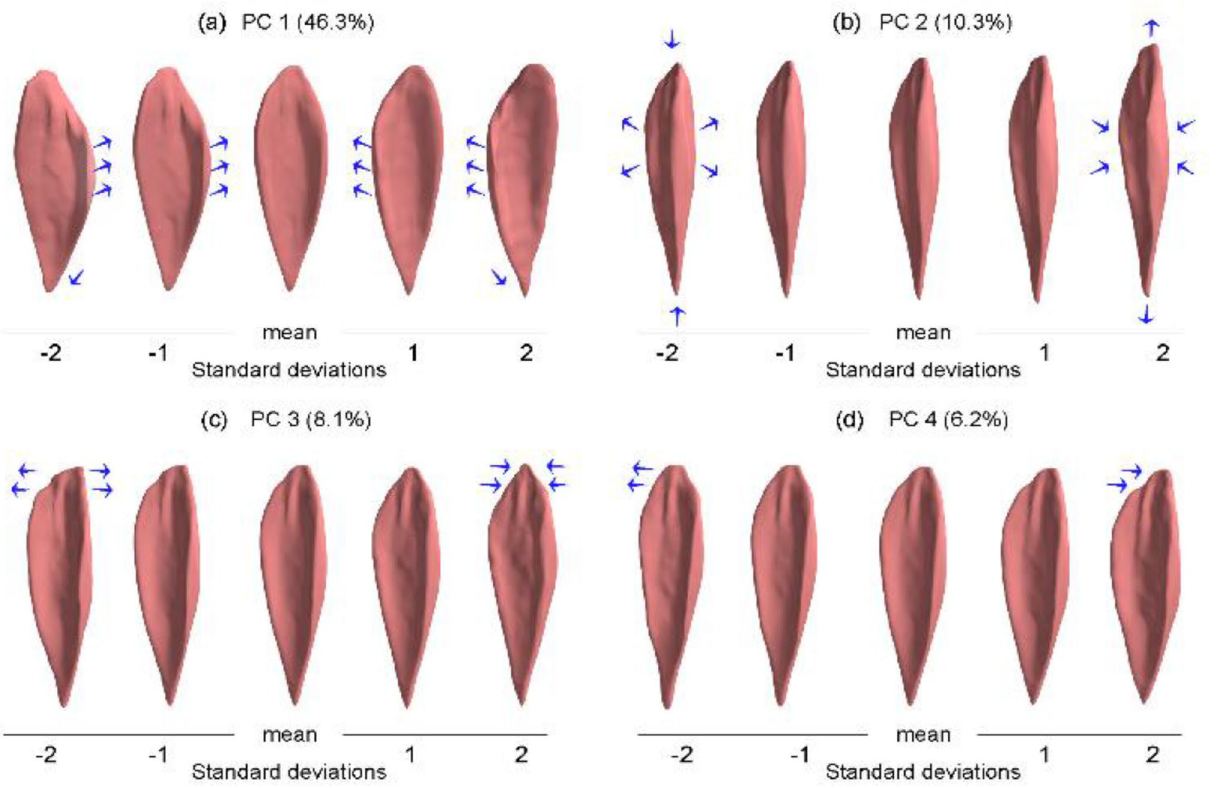
Figure 6. The variations of the soleus muscle along the principal components of the TD appearance (normalized) model and their variance percentages. The blue arrows indicate the change of the muscle shape. The first principal component ( a ) can be described by a widening of the curved marginal aspect of the soleus. The second principal component ( b ) represents a change of the muscle length combined with an inverse change of the muscle thickness and width. The third principal component ( c ) can be described as a change of the width of the proximal extremity of the muscle. The fourth principal component ( d ) represents a change at the proximal attachment region of the muscle.